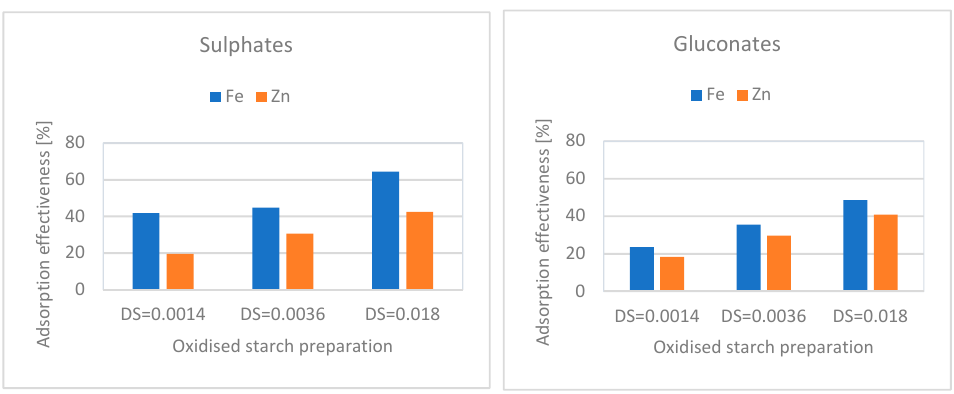
Figure 4. Effectiveness of the adsorption of iron and zinc sulphates and gluconates from the solutions containing 5 mg of individual cations per 1 g of starch preparation.